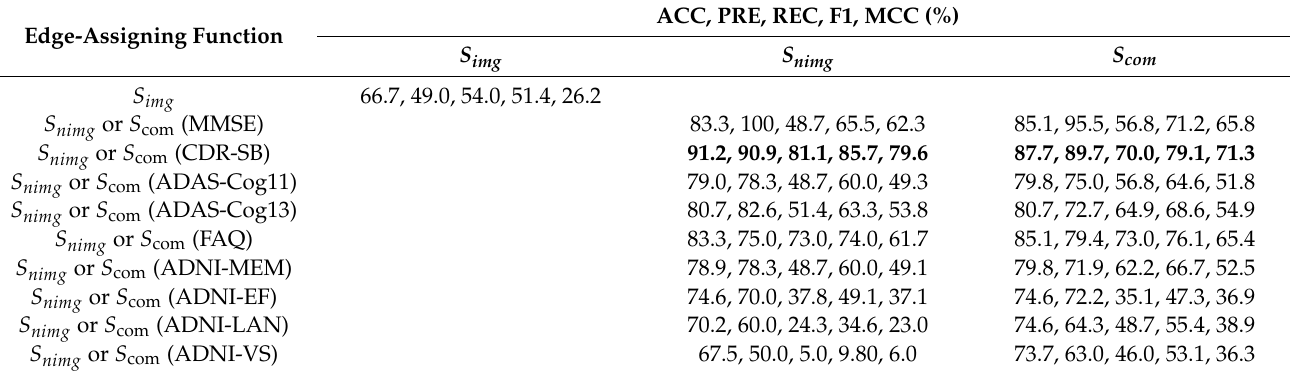
Table 4. GCN model performance under AD versus MCI task on the test data with different edge- assigning functions. The best results are given in